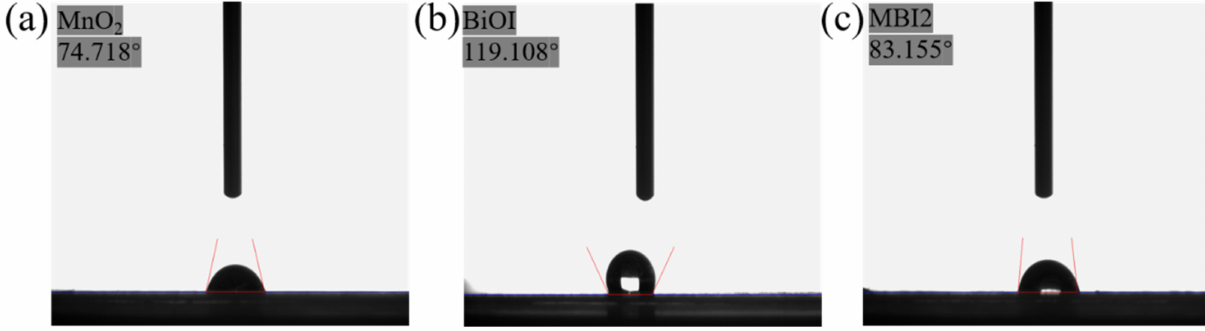
Figure 9. The contact angle of ( a ) pure α -MnO 2 , ( b ) BiOI, and ( c ) MBI2